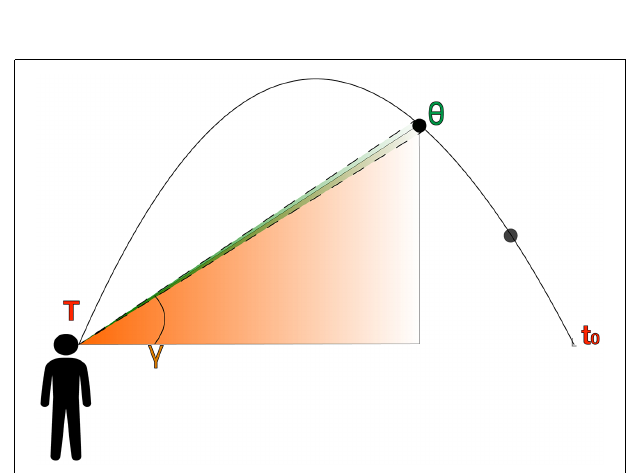
FIGURE 2 | Lateral view of a parabolic trajectory depicting the primary primitive monocular cues, that is, retinal size (green projection; θ ) and elevation angle (orange projection; γ